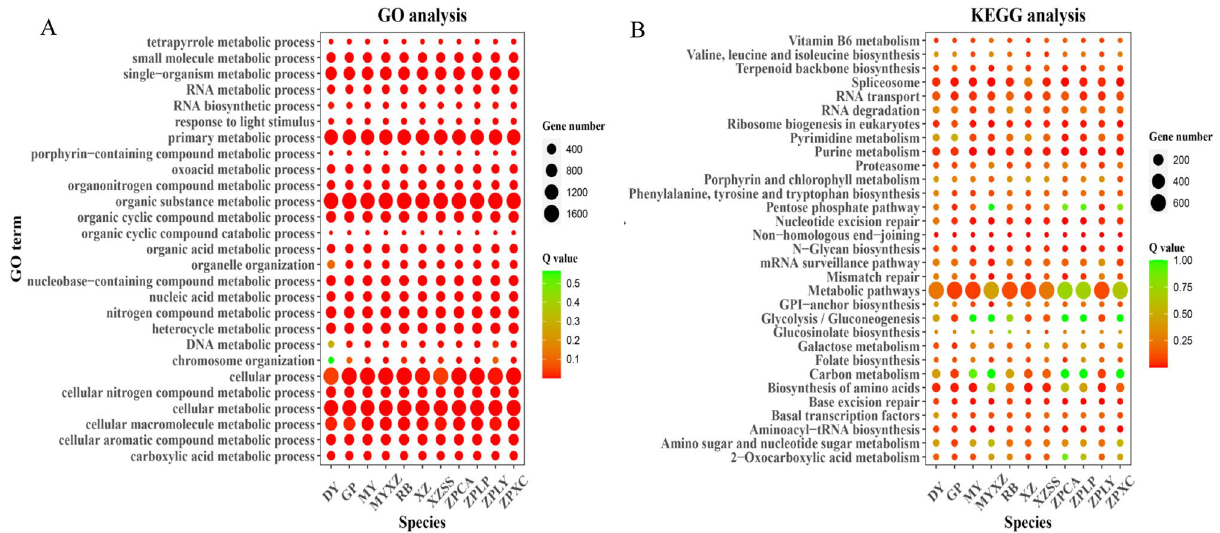
Figure 5. GO and KEGG analyses for common single-copy genes among 10 germplasms of Chaenomeles and D. delavayi . In this graph, the pot size indicates the number of enriched gene; the degree of significance decreases from red to green. In both the GO and KEGG analysis results, only the top15 GO terms and pathways are shown. The graphs were visualized by R